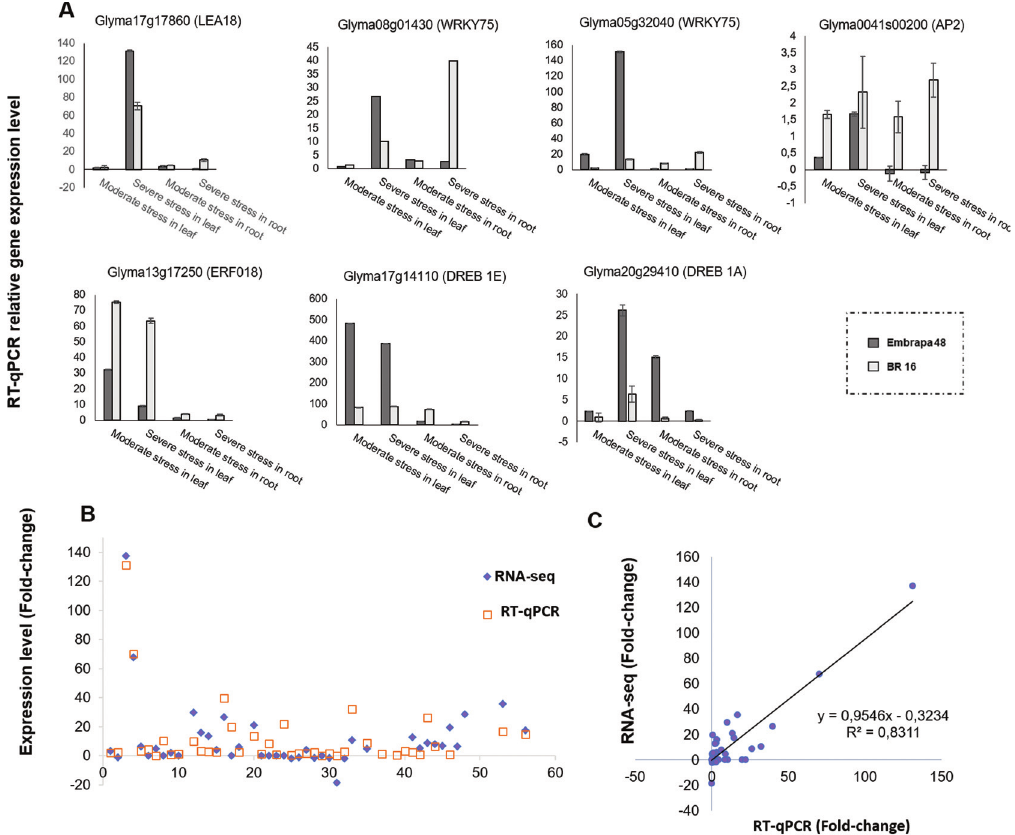
Figure 12 - Correlation between RT-qPCR and RNA-seq analyses of the seven genes selected in soybean cultivars under water deficit conditions: Glyma17g17860 ( LEA 18 ), Glyma08g01430 ( WRKY75 ), Glyma05g32040 ( AP2 ), Glyma0041s00200 ( AP2 ), Glyma13g17250 ( ERF018 ), Glyma17g14110 (DREB1E), andGlyma20g29410( DREB1A ).(A)RT-qPCRofthesevengenesaforementioned.Geneexpressionlevelisrelativetothecontrolplants(0min understress).Fold-change(y-axis)andtreatmentstoeachgene(x-axis).(B)RNA-seqandRT-qPCRresultsforthesevengenesvalidatedinEmbrapa48and BR 16 subjected to all stress treatments. (C) Correlation of the fold-change analyzed between RNA-seq (y-axis) and RT-qPCR